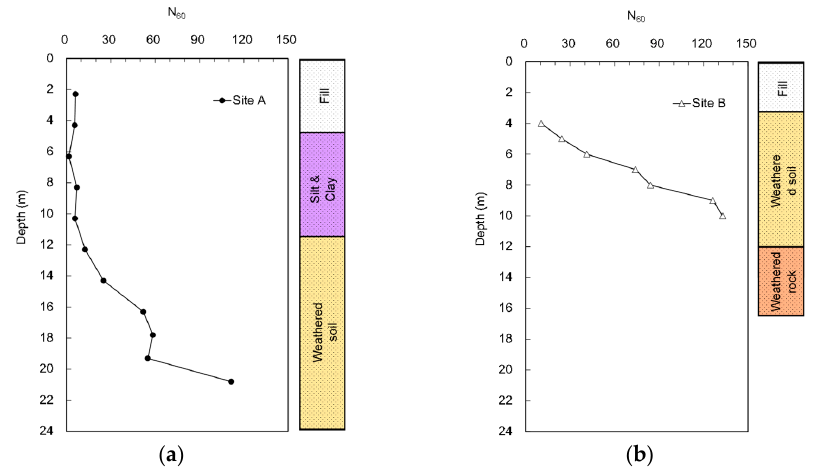
Figure 5. N value profiles measured from standard penetration test (SPT): ( a ) site A; ( b ) site B.